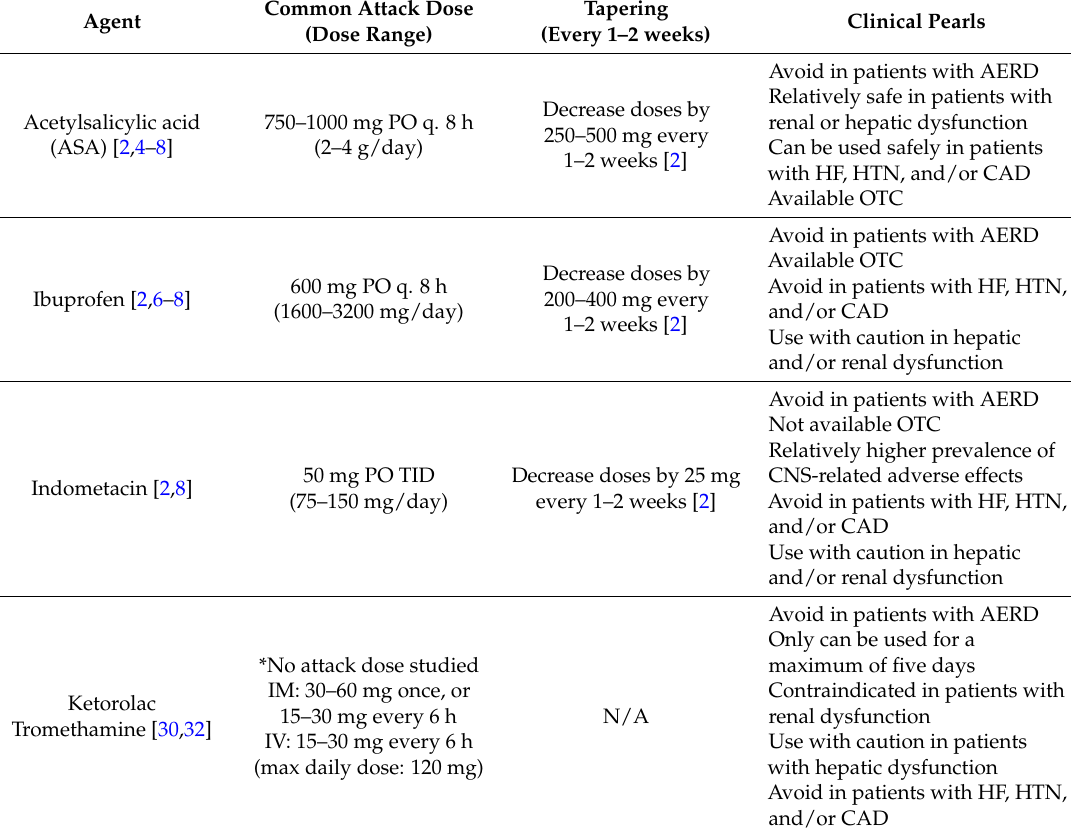
Table 1. NSAIDs and ASA in the Treatment of Acute and Recurrent Idiopathic